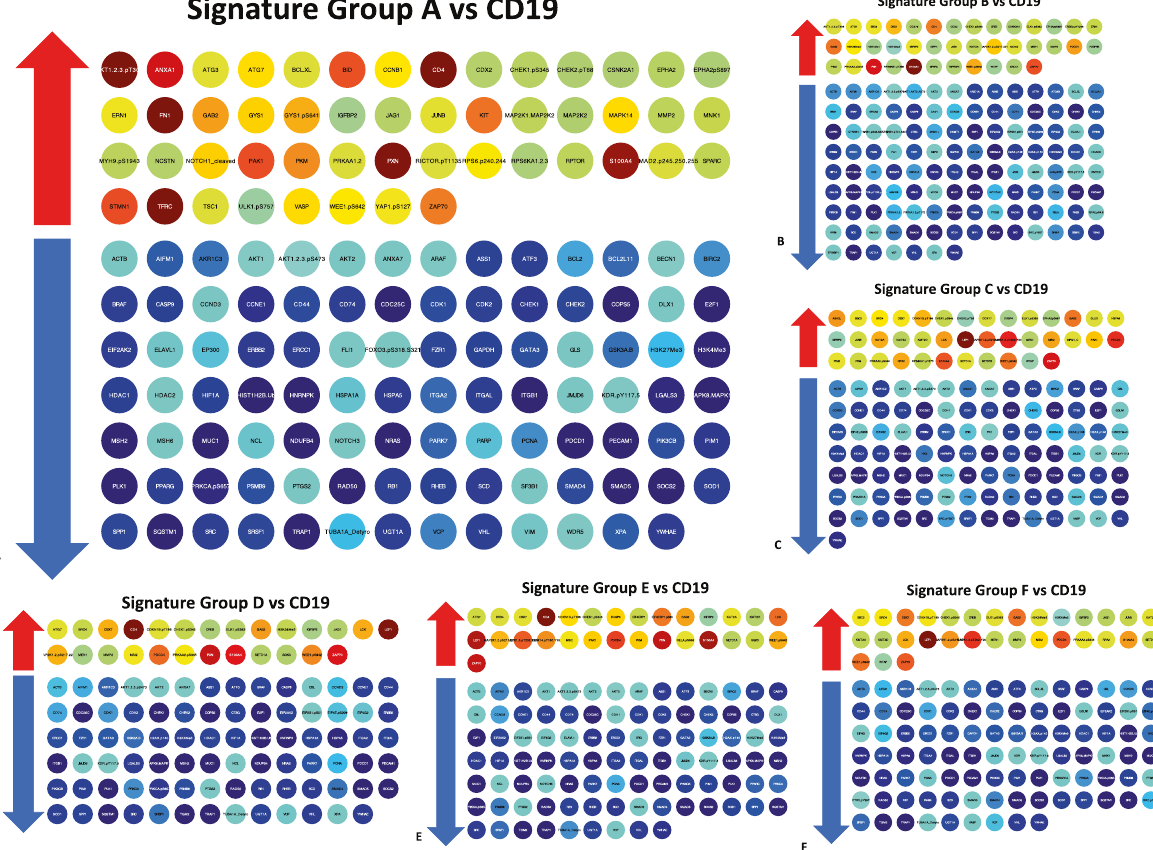
Fig. 6 Potential therapeutic targets for CLL signature groups. A – F Proteins differentially expressed ( p < 0.05) between CD19 controls and signature groups (designated by bold titles at the top of each panel). Upregulated proteins (adjacent to red arrows), that could serve as targets of inhibition, are represented with red – green – yellow colors based on median expression in each signature. Downregulated proteins (adjacent to blue arrows), which could serve as targets of replacement, are represented with cool blue